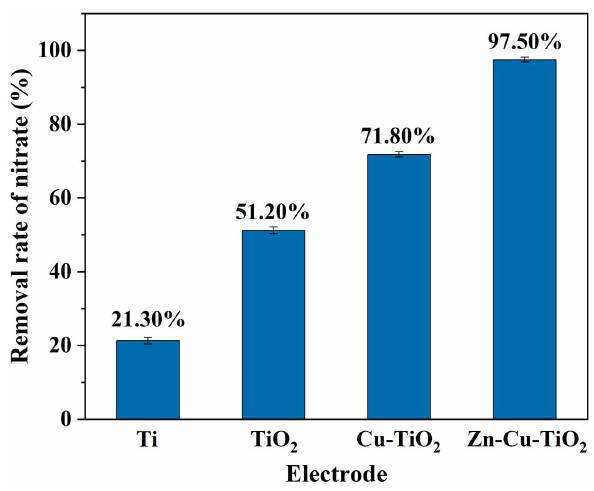
Figure 2. Electrode removal rate for each material. The surface morphology and elemental composition of the Zn-Cu-TiO 2 polymetallic nanoelectrodes were analyzed and processed using scanning electron microscopy (SEM) and energy dispersive spectroscopy (EDS) techniques, respectively, in turn. The bottom hole is the TiO 2 base layer, the gray irregular particles in the interlayer are a copper coating layer, and the top white irregular grain layer is a galvanized layer. From Figure 3a, it can be seen that there are many small particles of constituent substances on the TiO 2 nanoporous matrix in the Zn-Cu-TiO 2 polymetallic nanoelectrodes. Energy dispersive spectra of the Zn-Cu-TiO 2 polymetallic nanoelectrode are shown in Figure 3b. Copper and zinc are uniformly distributed on the porous titanium dioxide nanosubstrate. Figure 3c shows the distributions for different elements, which further proves that copper and zinc are uniformly distributed.